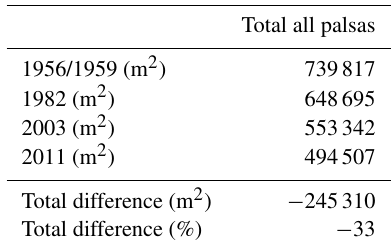
Table 3. Area of all palsas and peat plateaus in Suossjavri for 1956/1959, 1982, 2003 and 2011, with total differences of the area between 1956/1959 and